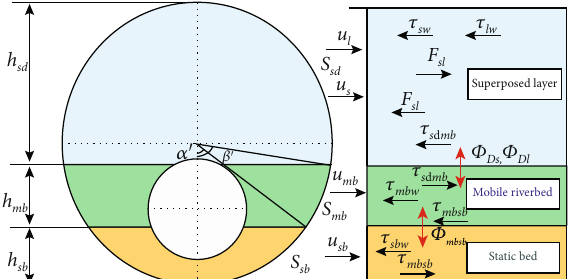
Figure 2: Three-layer model of cuttings migration in the horizontal annulus